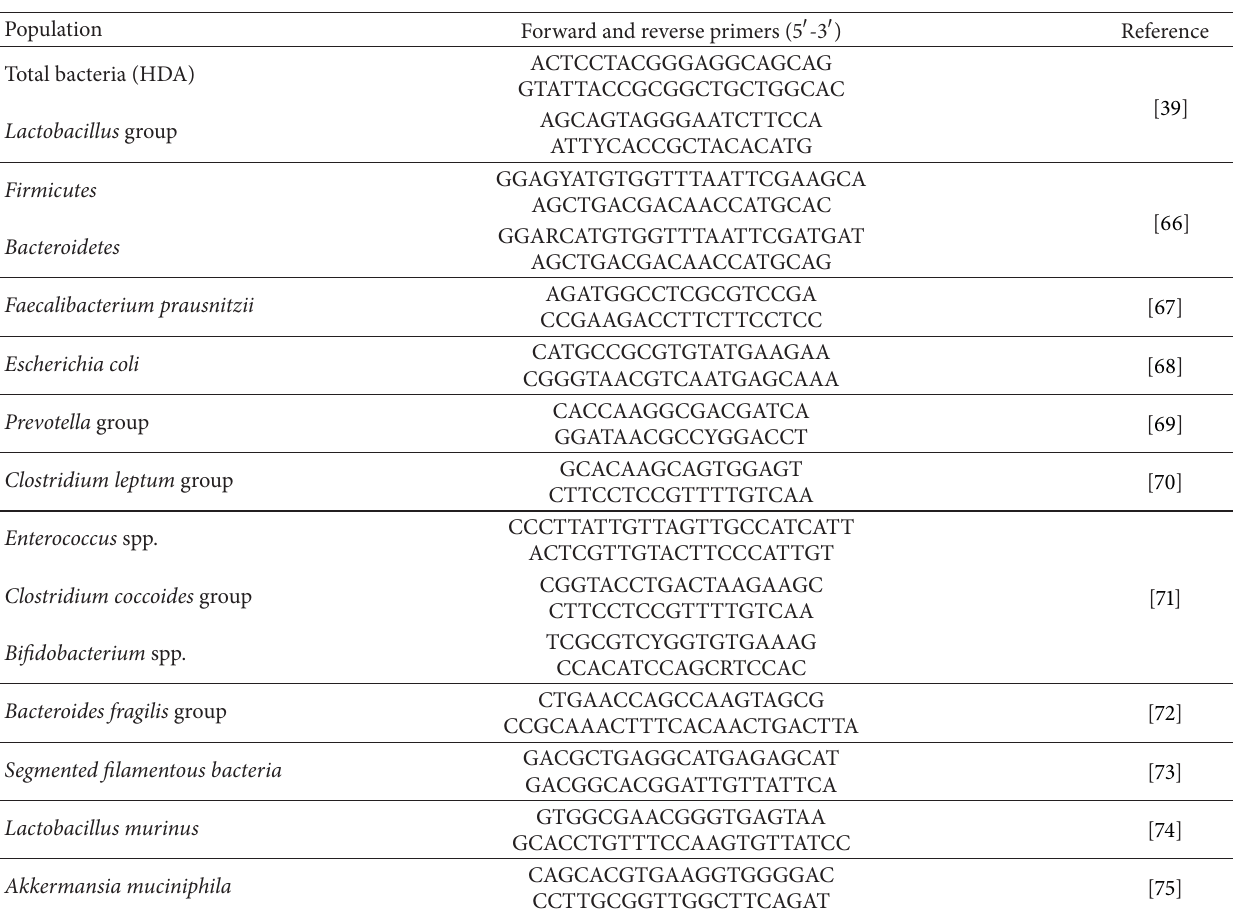
Table 1: Sequences of oligonucleotide primers.